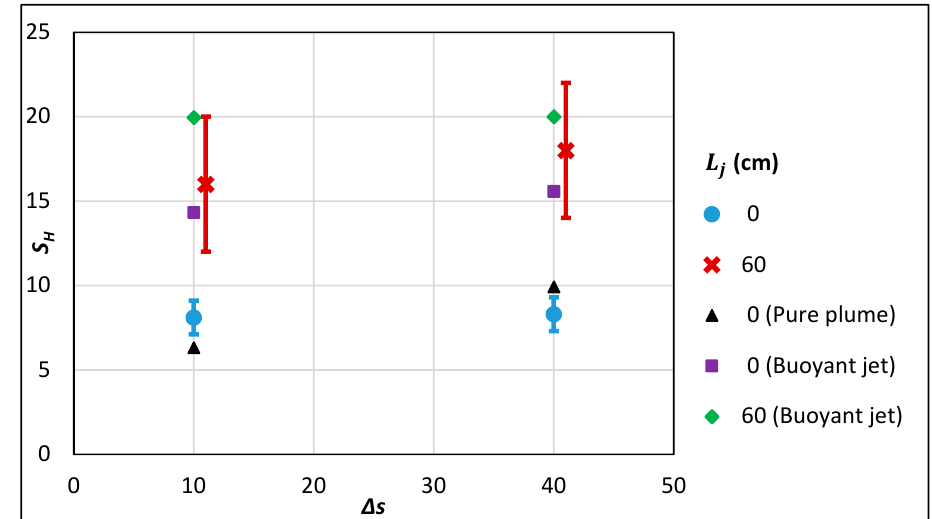
Figure 7. Dilutions measured along the bottom of the tank at R = 0 plotted against ∆ s . (The abscissas of various measurements are shifted slightly so that all symbols are visible. s w = 0 for all runs plotted.) The pure plume dilution is calculated using Equation (8). The buoyant jet dilutions are calculated using Figure 8.7 from Section 9.2.3 of [40].